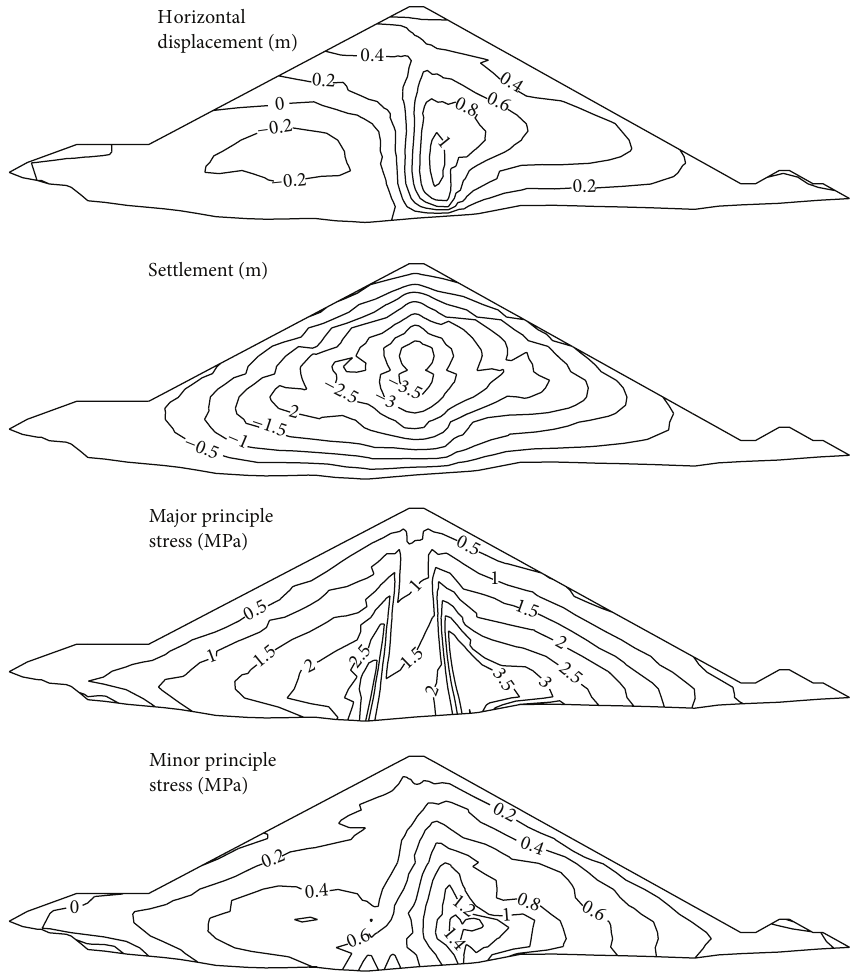
Figure 11: Displacement and stress distribution at